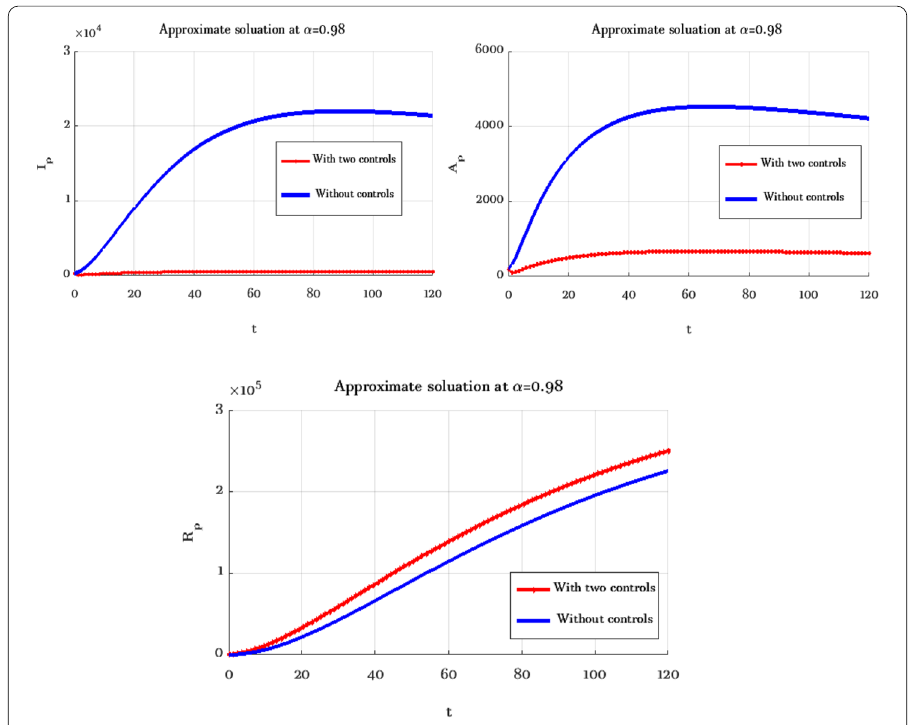
Figure 1 Numerical simulations of I p , A p , and R p at α = 0.98, (cid:21) = 1 with and without controls